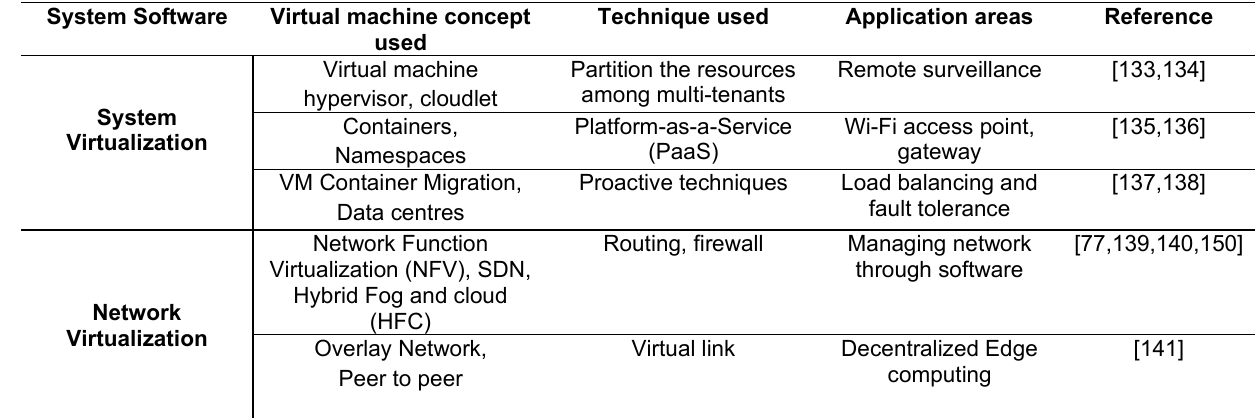
Table 4. System Software for IoT Infrastructure